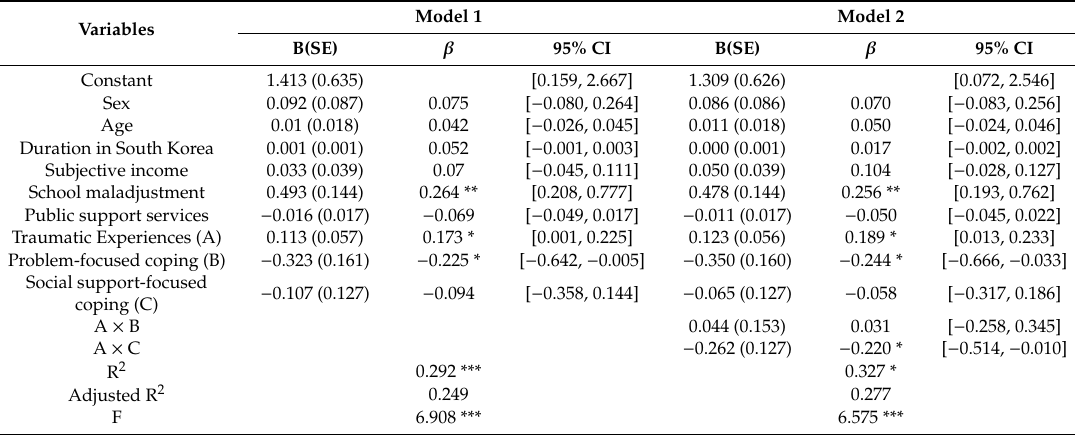
Table 2. Multivariable regression of negative health perception ( N =